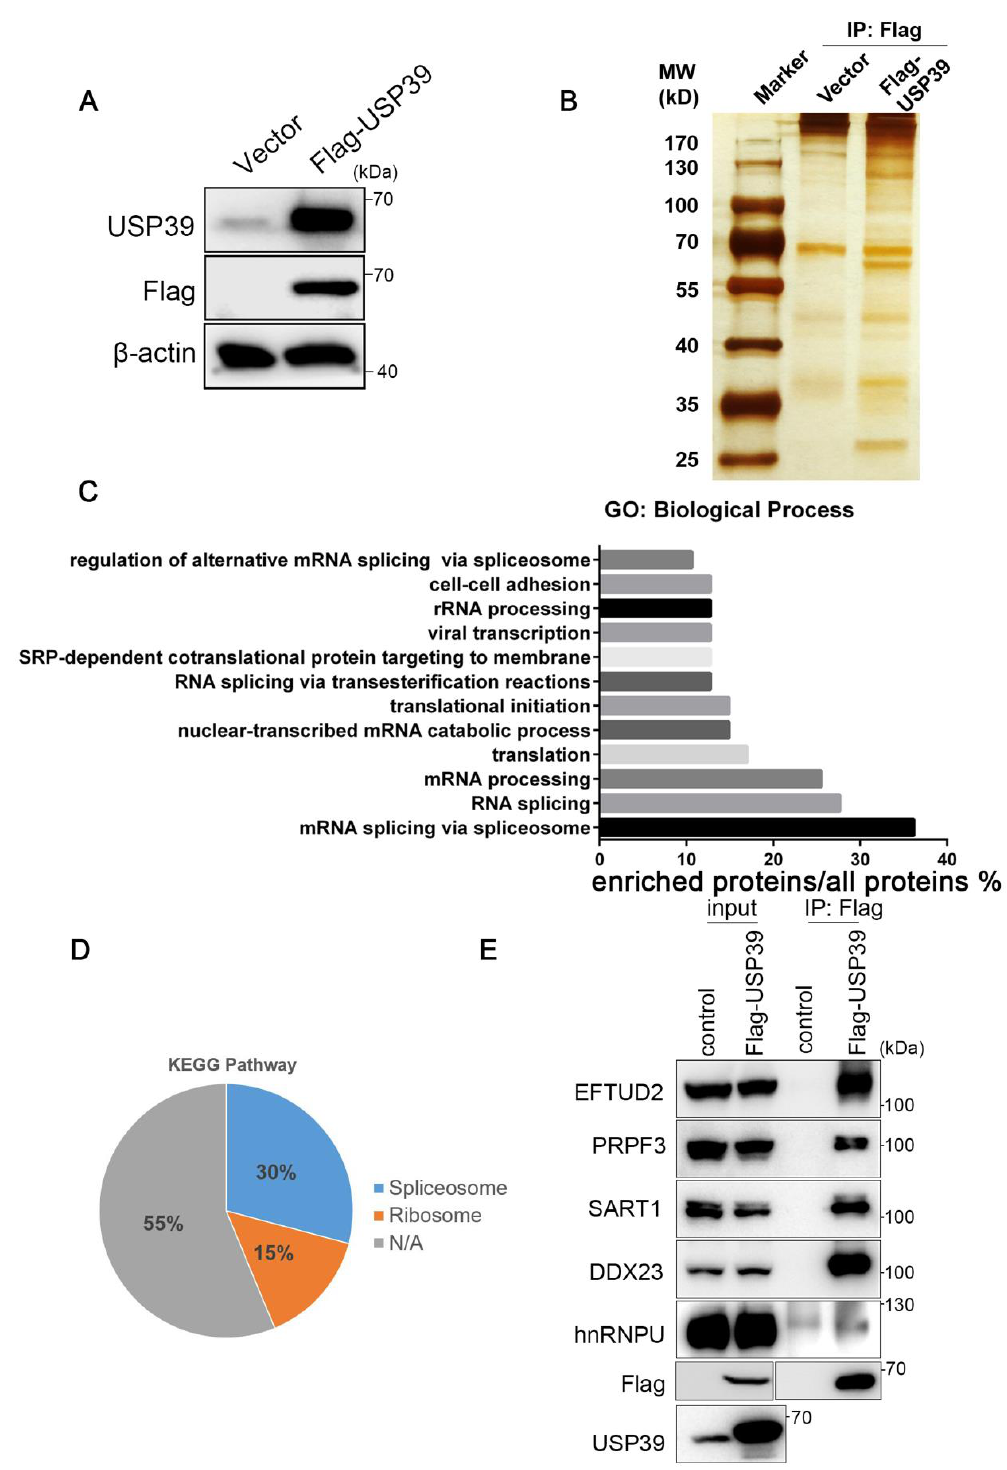
Figure 4. USP39 interacts with several spliceosome components. ( A ) Overexpression efficiency of USP39 in KYSE30 cells was determined by Western blot. ( B ) The USP39 stable expression clone was established. Proteins that interacted with USP39 were purified from KYSE30 cells expressing Flag-tagged USP39 or vector control. ( C ) GO enrichment analysis of proteins pulled down by Flag antibody from KYSE30 cells expressing Flag-tagged USP39. ( D ) KEGG pathway analysis of proteins pulled down by Flag antibody from KYSE30 cells expressing Flag-tagged USP39. ( E ) The interaction between USP39 and core spliceosome factors was validated by Co-IP in KYSE30